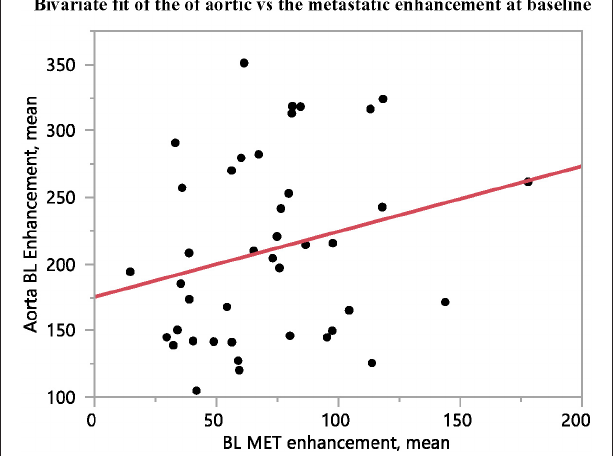
FIGURE 3 | The contrast-enhancement in the abdominal aorta at the level of the coeliac trunk shows no correlation to the contrast-enhancement of the